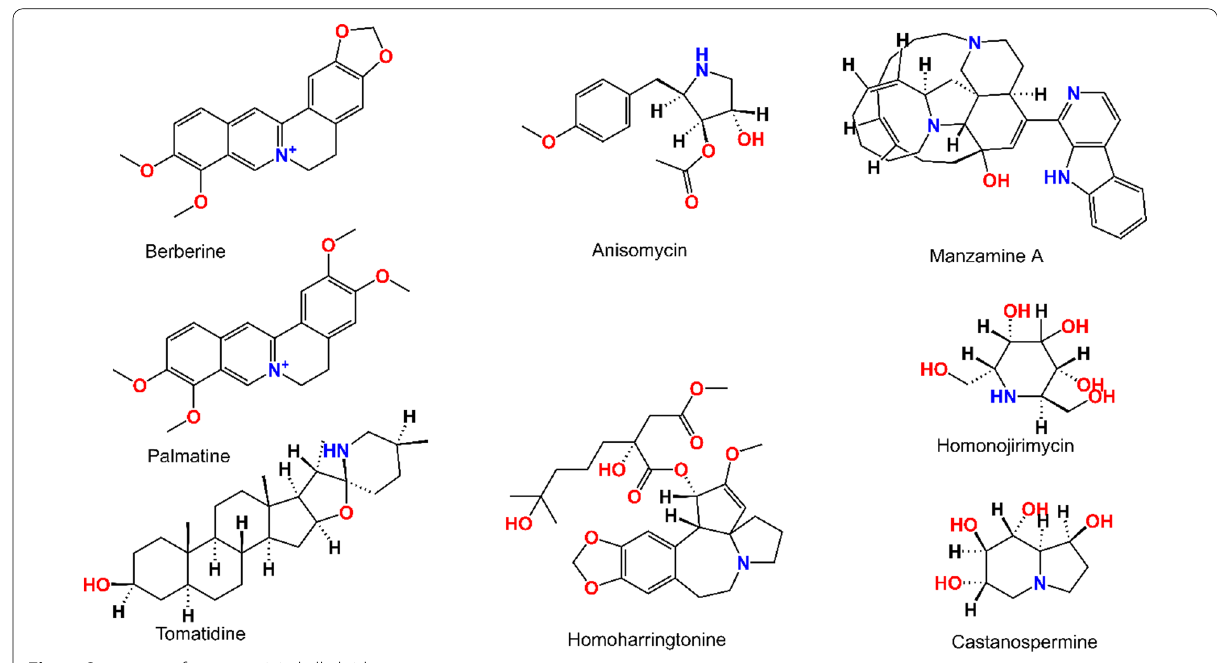
Fig. 1 Structures of some antiviral